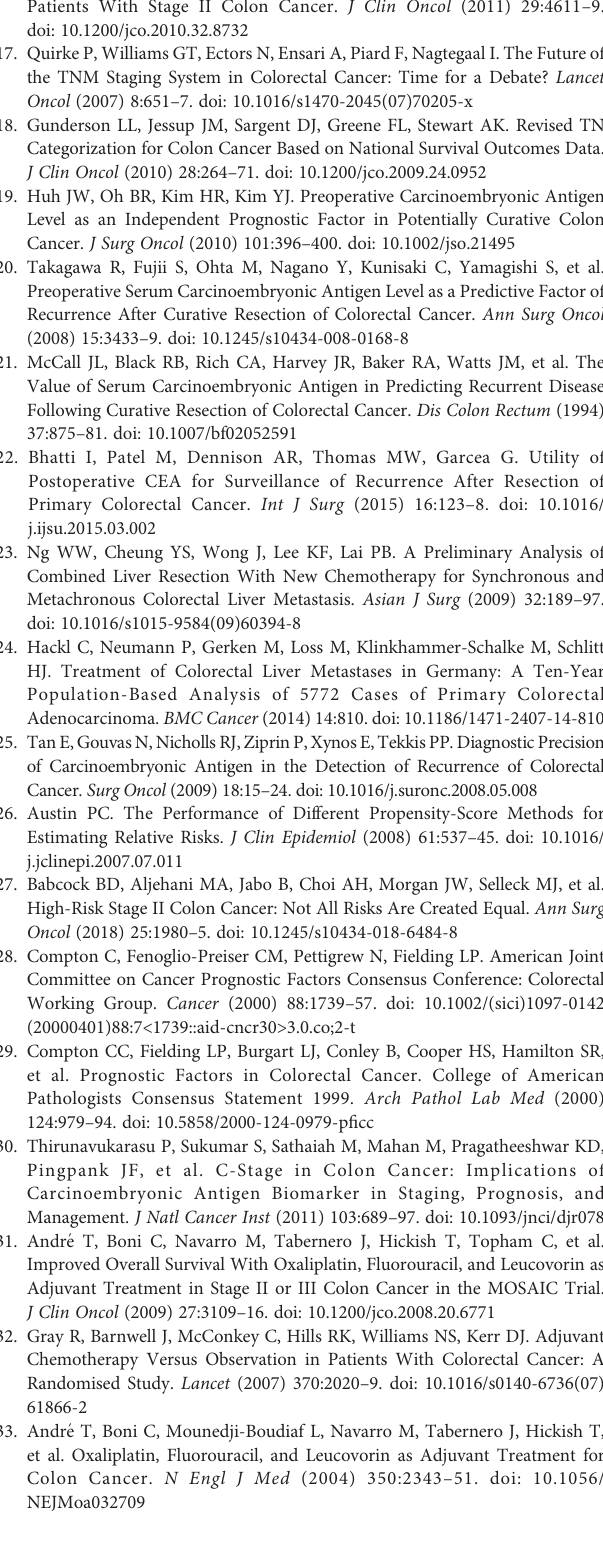
Supplementary Figure2 | The receiver operating characteristics (ROC) curves of the CEA ratio and CEA absolute value with respect to OS.